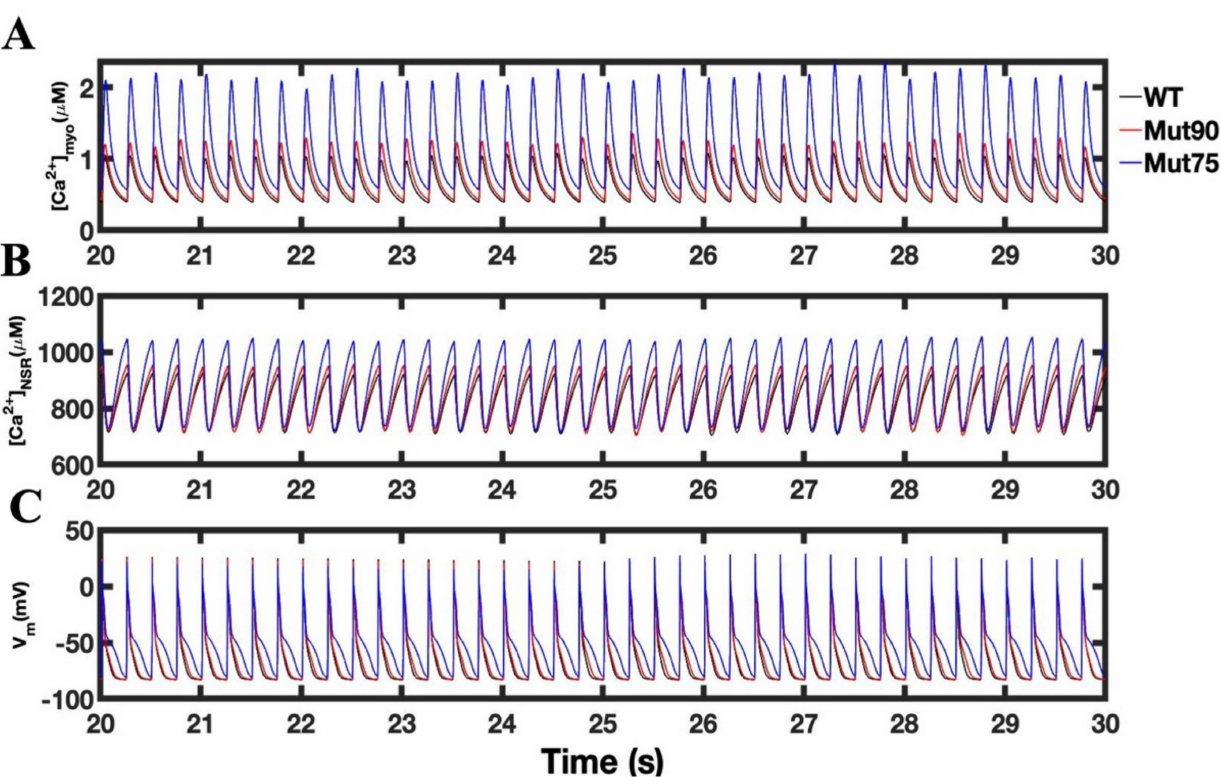
Figure 8. The cardiac myocyte at 4 Hz pacing for 100 s shows that the simulation reaches steady state after 20 s. ( A ) Myoplasmic calcium. Pictured here is the simulation from 20 to 30 s. ( B ) SR calcium. ( C ) Transmembrane voltage. Shown are normal (black) and mutant cells with diminished CaM -dependent LCC inactivation. (Red—wild type, 75% of CDI transition rate—blue, and 90% of CDI transition rate—red). Shown are representative simulations out of six repeated simulations with different random number seed values in each case. The different simulation traces for each condition overlap at steady-state